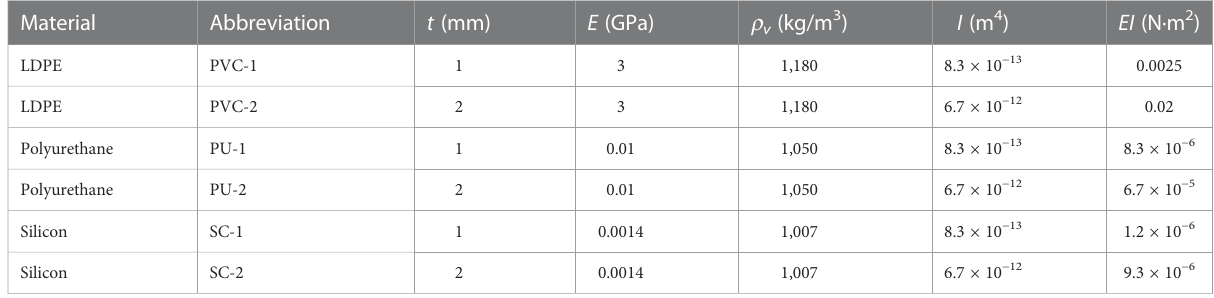
TABLE 1 Physical parameters of the model